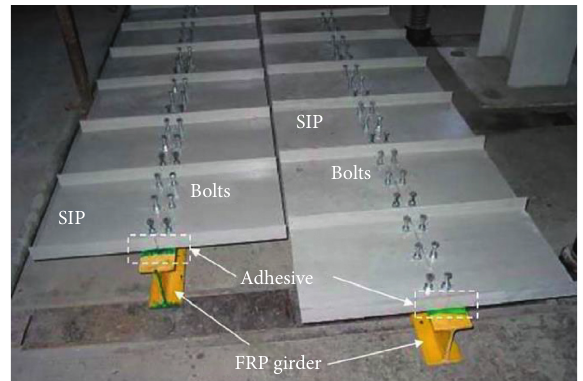
Figure 26: FRP-concrete hybrid beams proposed before